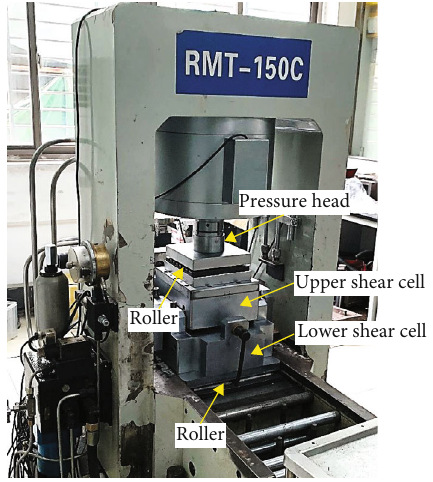
Figure 5: Direct shear test by RMT – 150C servo test